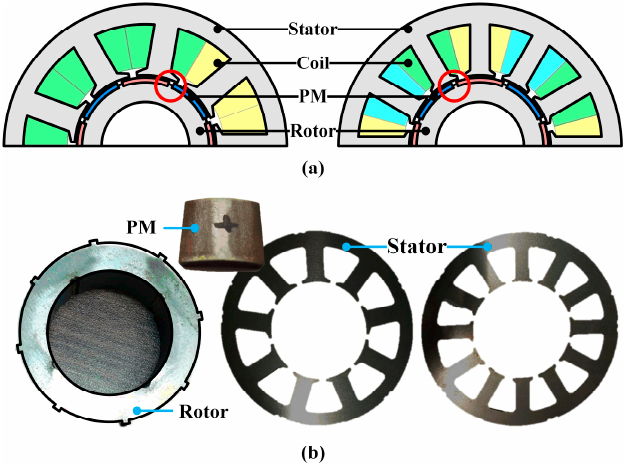
Figure 1. The analysis model of permanent magnet machines with two different pole/slot combinations: ( a ) electromagnetic analysis model and ( b ) prototype model.